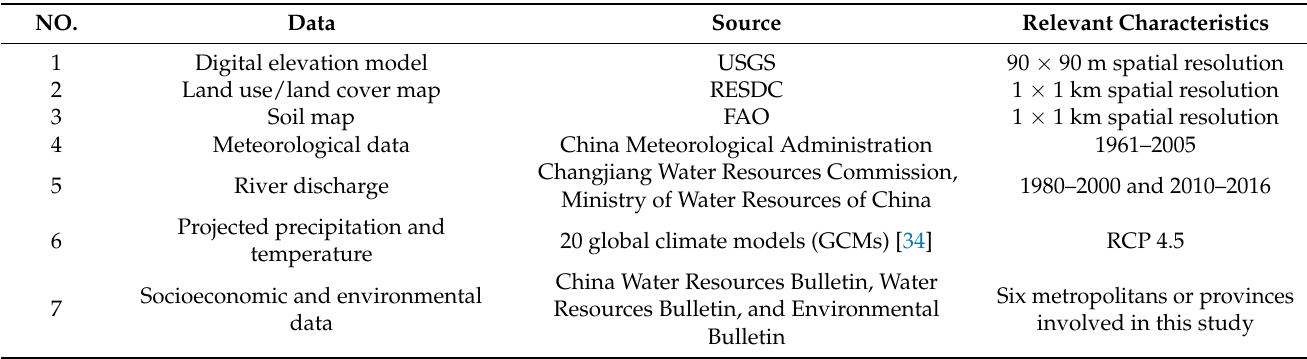
Table 1. Data descriptions and sources in this